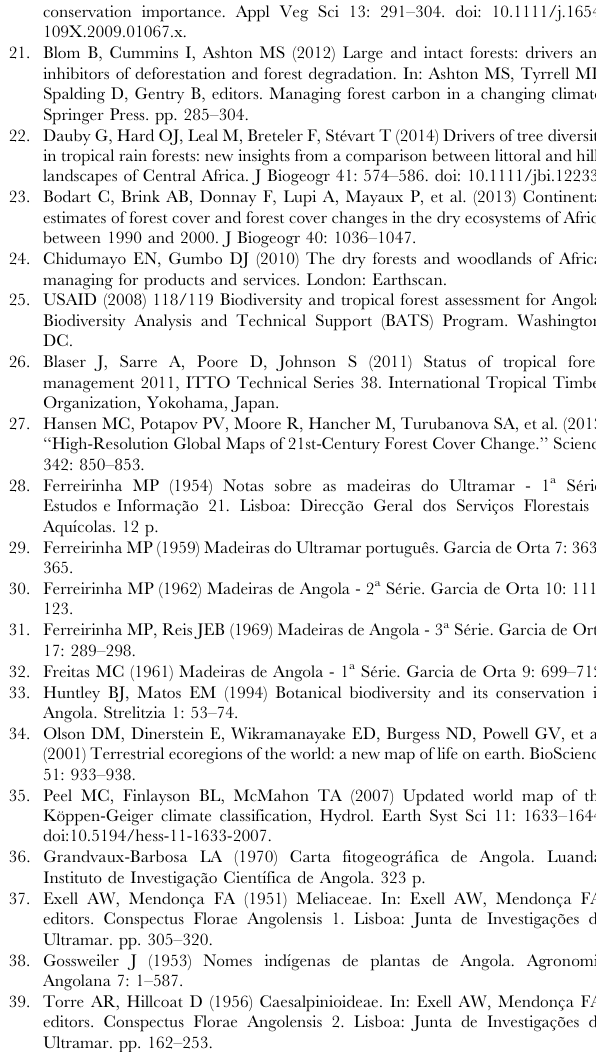
Table S3 Data provider per species accessed through GBIF data portal for each of the 18 timber species considered in this study. Accessed 29 April 2013.